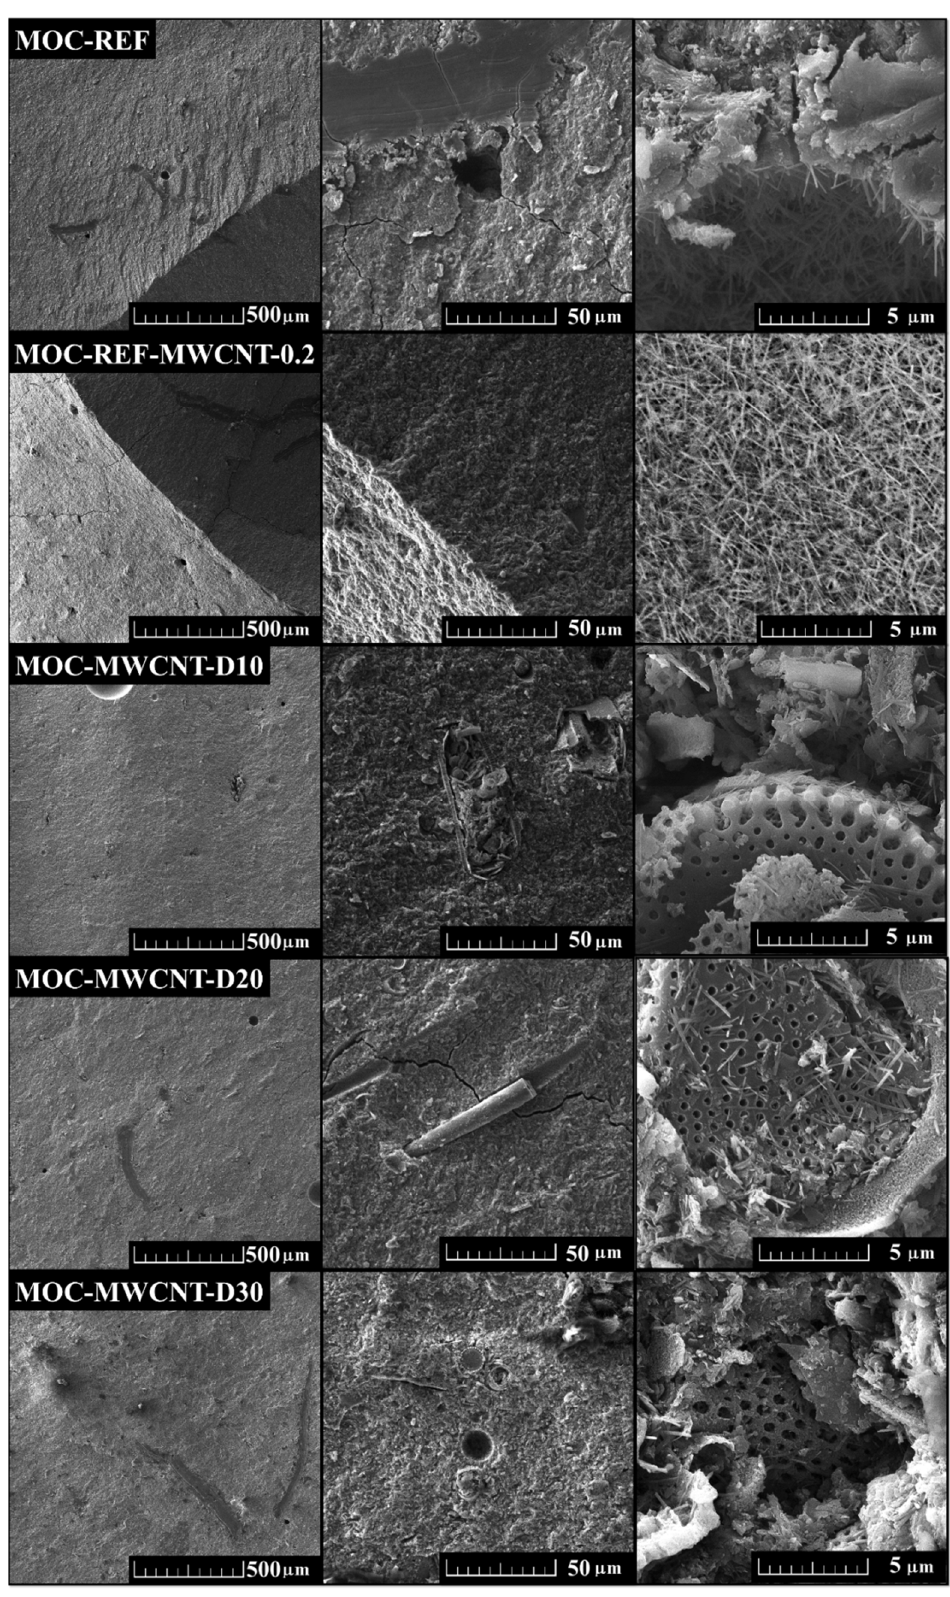
Figure 3. The SEM micrographs of the obtained MOC-based composite materials. The phase composition of the samples was studied by X-ray diffraction. All diffrac- tograms have shown the content of the MOC phase 5 (Mg 3 (OH) 5 Cl·4H 2 O, ICDD 04-014-